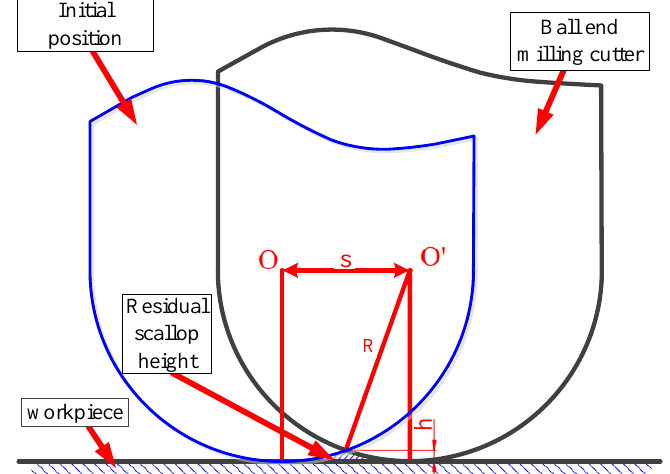
Figure 1. Scallop height in flat surface machining.